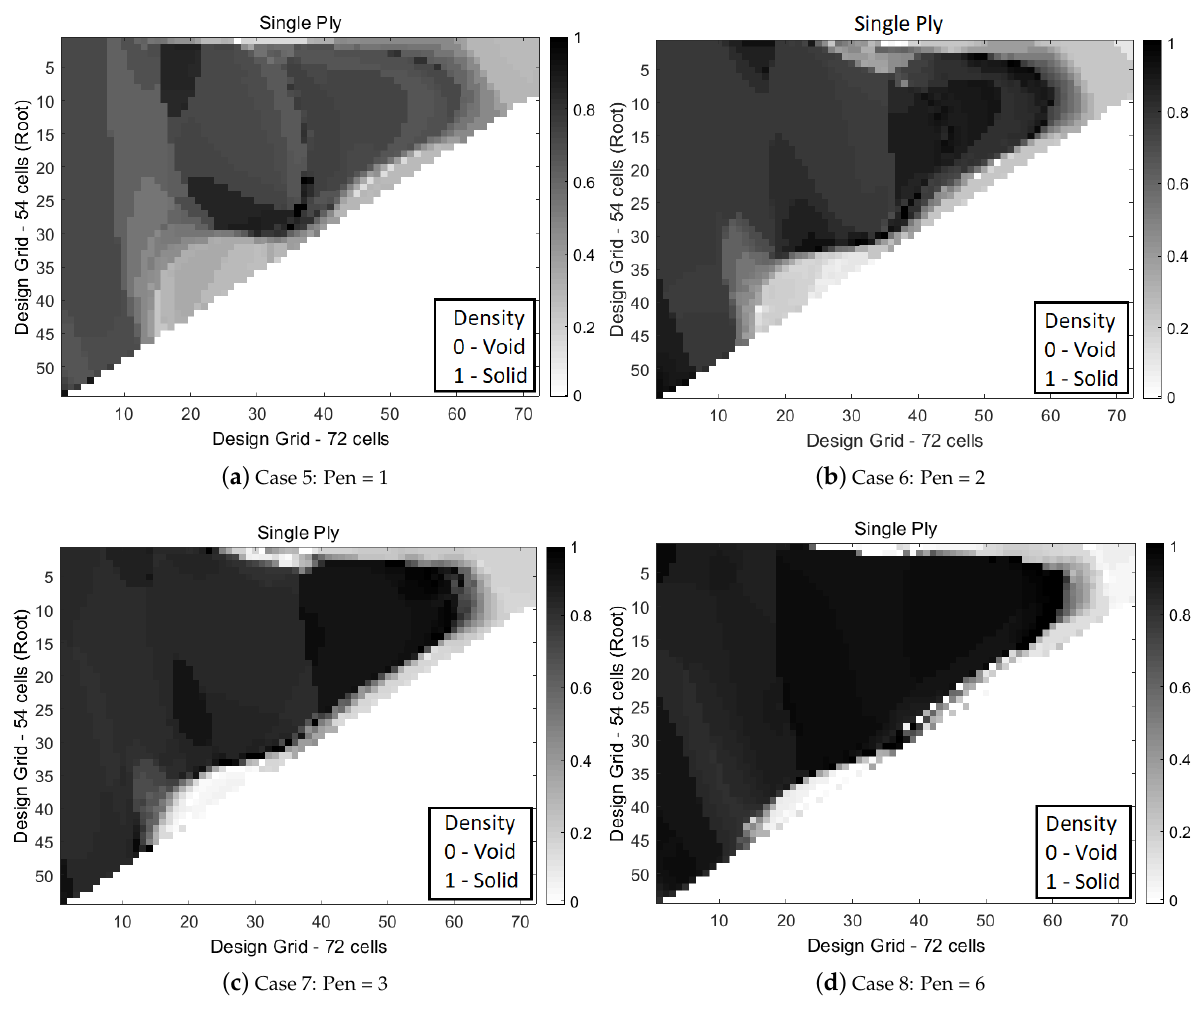
Figure 15. Dynamically Scaled structure-Comparison about penalization factor (Pen = 1, 2, 3 and 6) using no projection